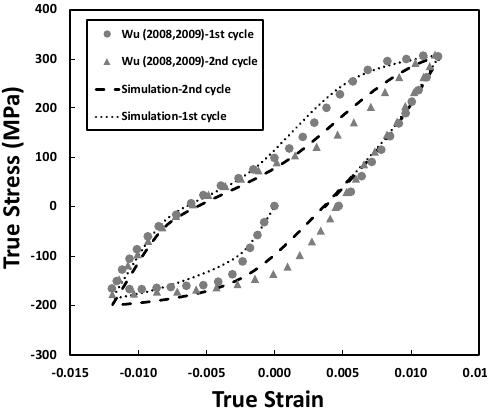
Figure 14. Comparison of the predicted stress ‐ strain curve versus the experimental results of Wu et al. [17] and Wu [107] during the cyclic loading along the extrusion direction in ZK60A Mg alloy (After Yaghoobi et al. [9]).